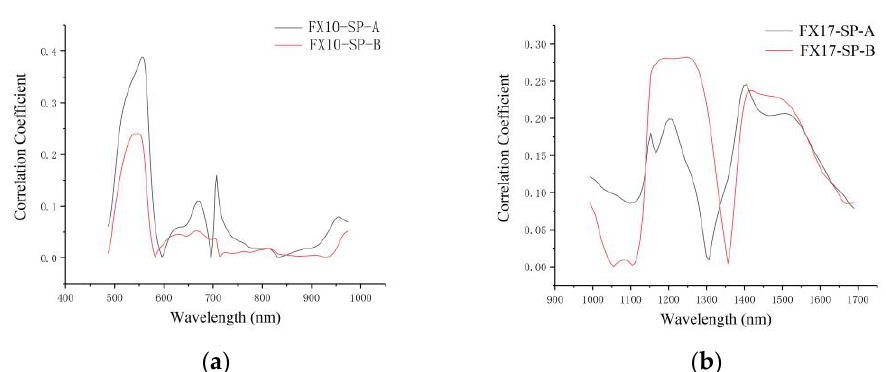
Figure 5. Correlation coefficient corresponding to the wavelengths. ( a ) Correlation coefficient curves of VIS/NIR averaging spectra (FX10); ( b ) correlation coefficient curves of NIR averaging spectra (FX17).